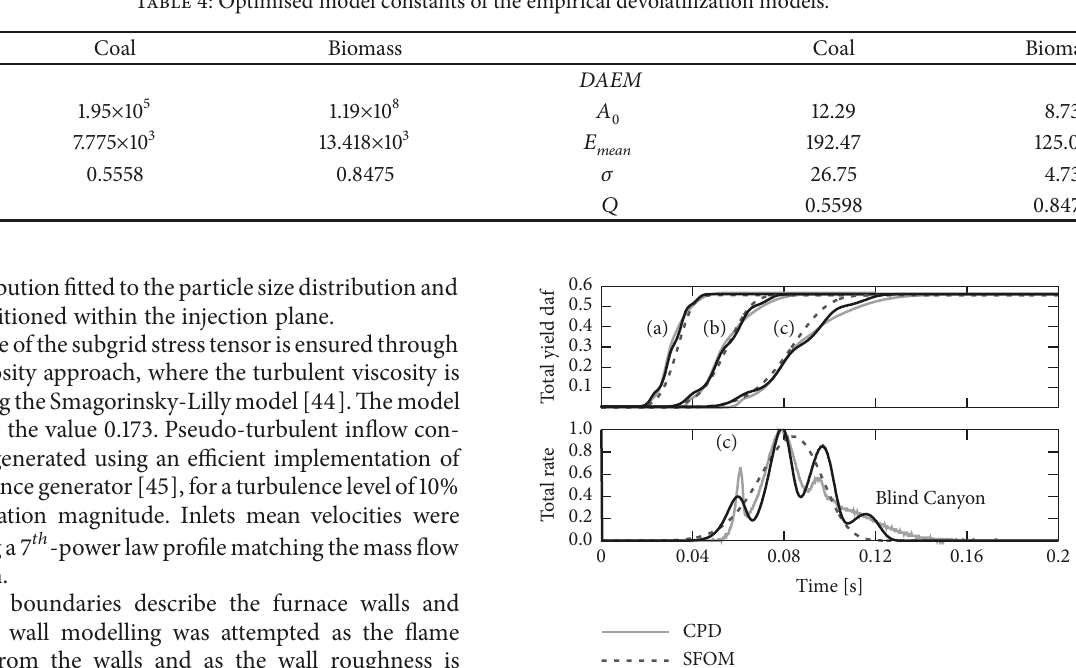
Table 4: Optimised model constants of the empirical devolatilization models.